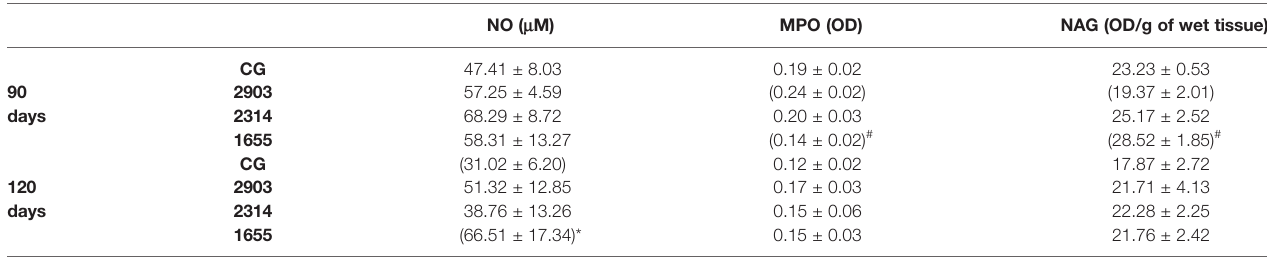
Thedata areexpressed as mean ±SE (n= 4).*p < 0.05comparing 1665 toCG at120days. # p< 0.05comparing 1655to 2903at 90days. CG, control group.2903: group infected with MHOM/BR/1975/M2903. 2314, group infected with MHOM/BR/2003/2314. 1655, group infected with MHOM/BR/2000/1655. NO, nitric oxide dosage; MPO, enzymatic activity